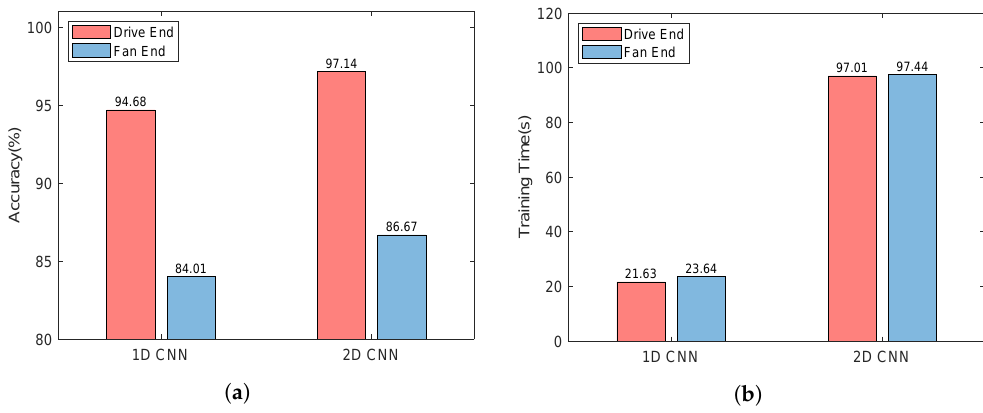
Figure 3. Accuracy and training time comparison of different CNN